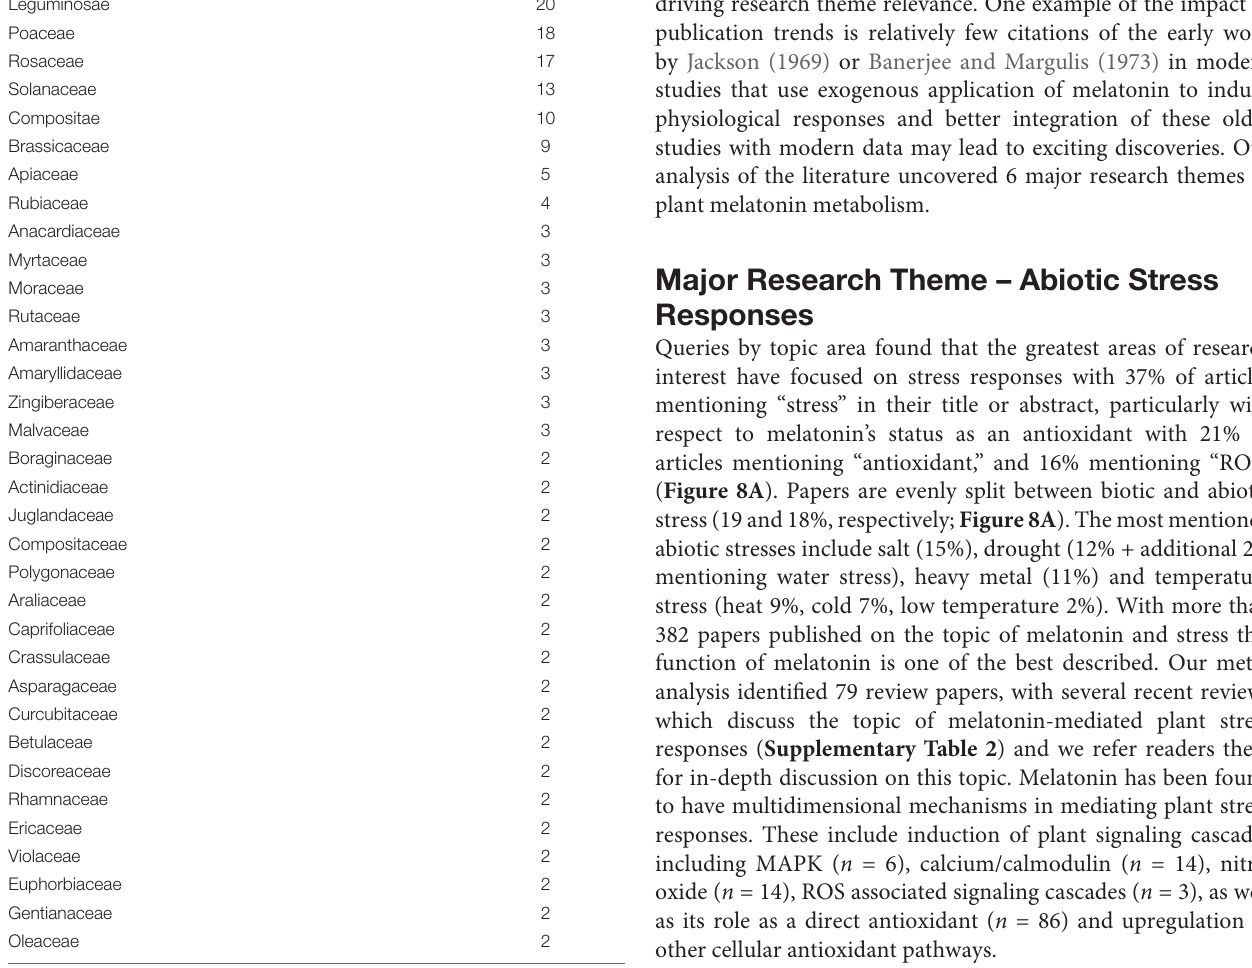
type of melatonin exposure ( Figure 9A ), and type of study ( Figure 9C ). A network analysis by digital object identifier (DOI) identified relationships between the literature themes such that some aspects are over-represented, and some are undervalued in the current publication database ( Figure 10